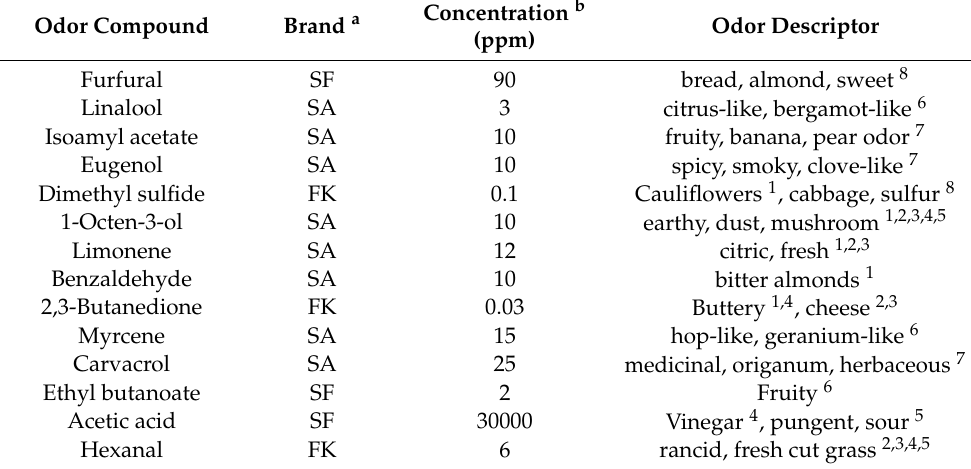
Table 1. List of fourteen odor compounds used during panel